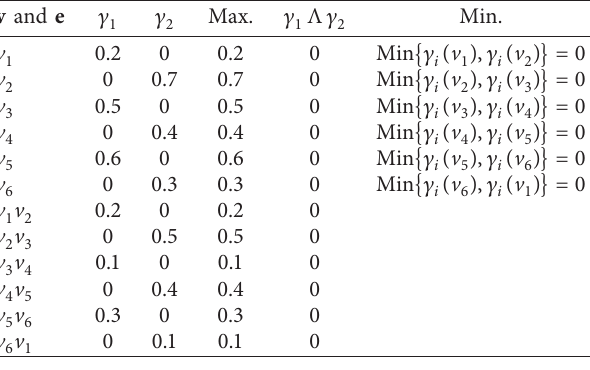
Table 1: Example of the total coloring of a fuzzy graph G � ( V, σ , μ )